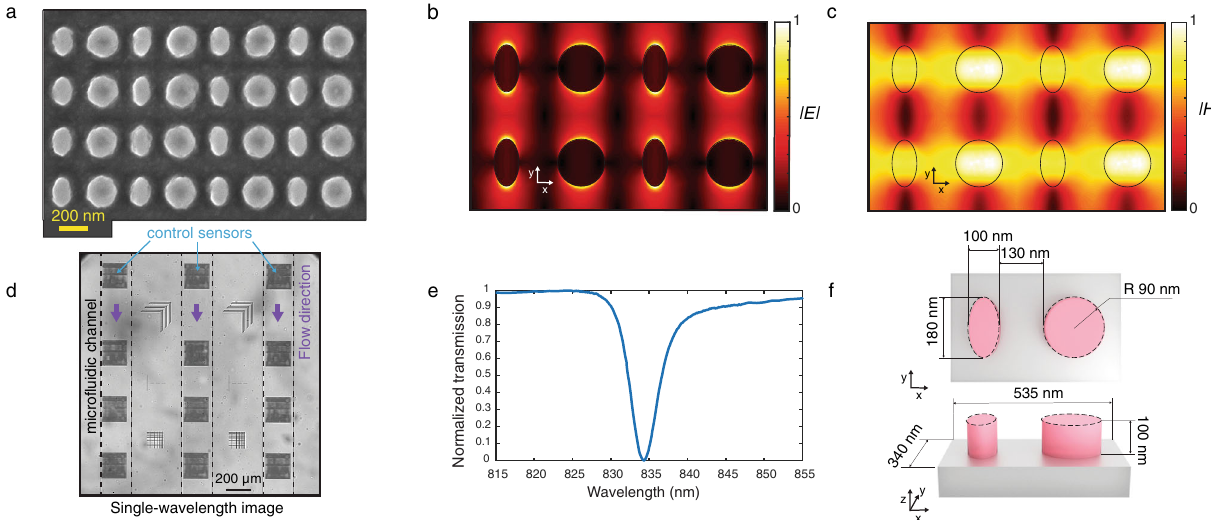
Fig. 2 Diatomic dielectric metasurface supporting high quality factor quasi-BIC resonances. a Scanning electron microscopy (SEM) image of the fabricated dielectric metasurface. To prevent charging while taking SEM images, we applied a thin layer of Electra, a carbon-based conductive polymer. b , c Distributions of electric and magnetic fi elds, respectively, in four neighboring metaunits from numerical calculations. d A region of interest from an intensity image obtained at the resonance wavelength of the integrated opto fl uidic chip showing 3 × 4 all-dielectric metasurface sensors and borders of the three Polydimethylsiloxane (PDMS) fl ow channels. e Experimentally acquired transmission spectrum of the fabricated dielectric metasurfaces in y- polarization. f Top and side-views schematic of the metaunit composed of an elliptical (long and short axis 180 nm and 100 nm respectively) and a cylindrical (90 nm in radius) a-Si